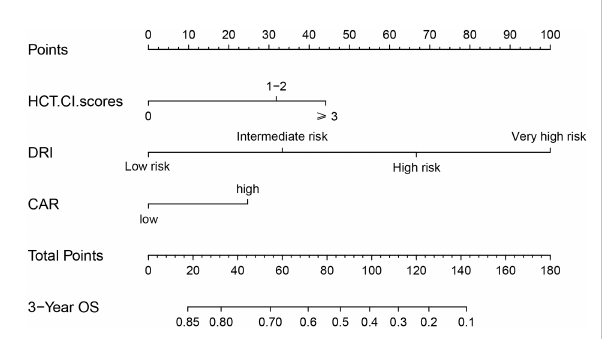
FIGURE 3 Nomogram of OS for patients with haplo-HSCT. Low CAR: ≤ 0.109; High CAR: